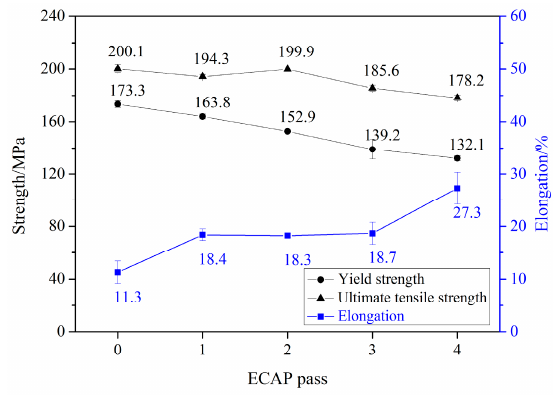
Figure 7. The mechanical properties evolution versus ECAP pass.